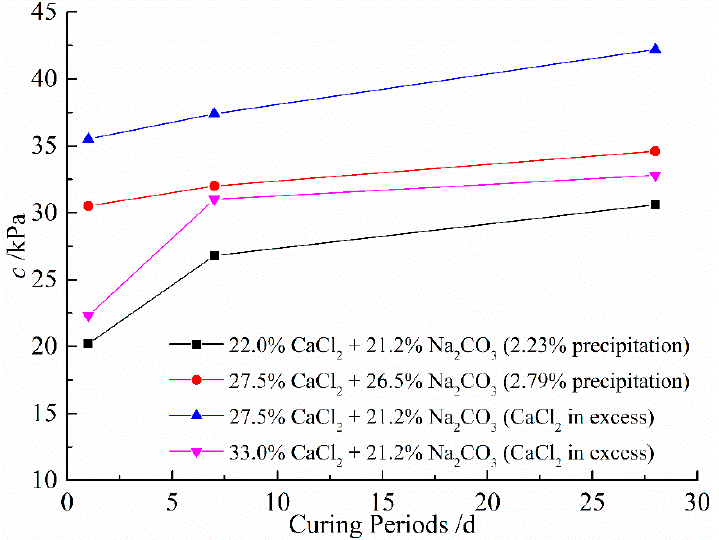
Figure 10. Variations of cohesion with different concentrations of solutions versus curing periods.